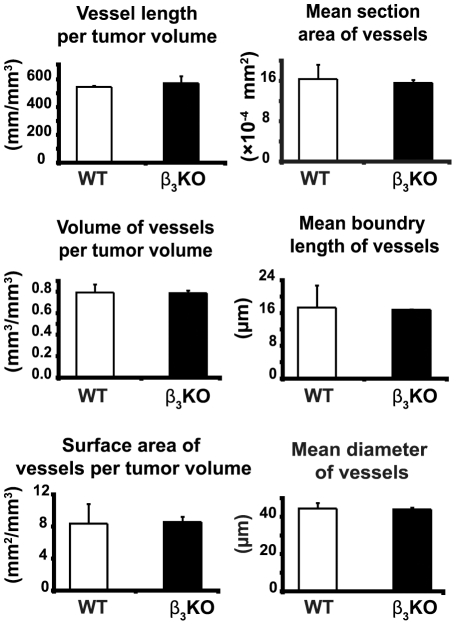
Quantitative analyses of vascular parameters.Stereology of CD31-positive vessels in CT26 carcinomas grown in integrin β3-deficient (n = 9) and WT mice (n = 6). 6 µm sections stained for CD31 by immunohistochemistry were counted, ×200 magnification. Data was analyzed with Student's t-test. Error bars are SEM.